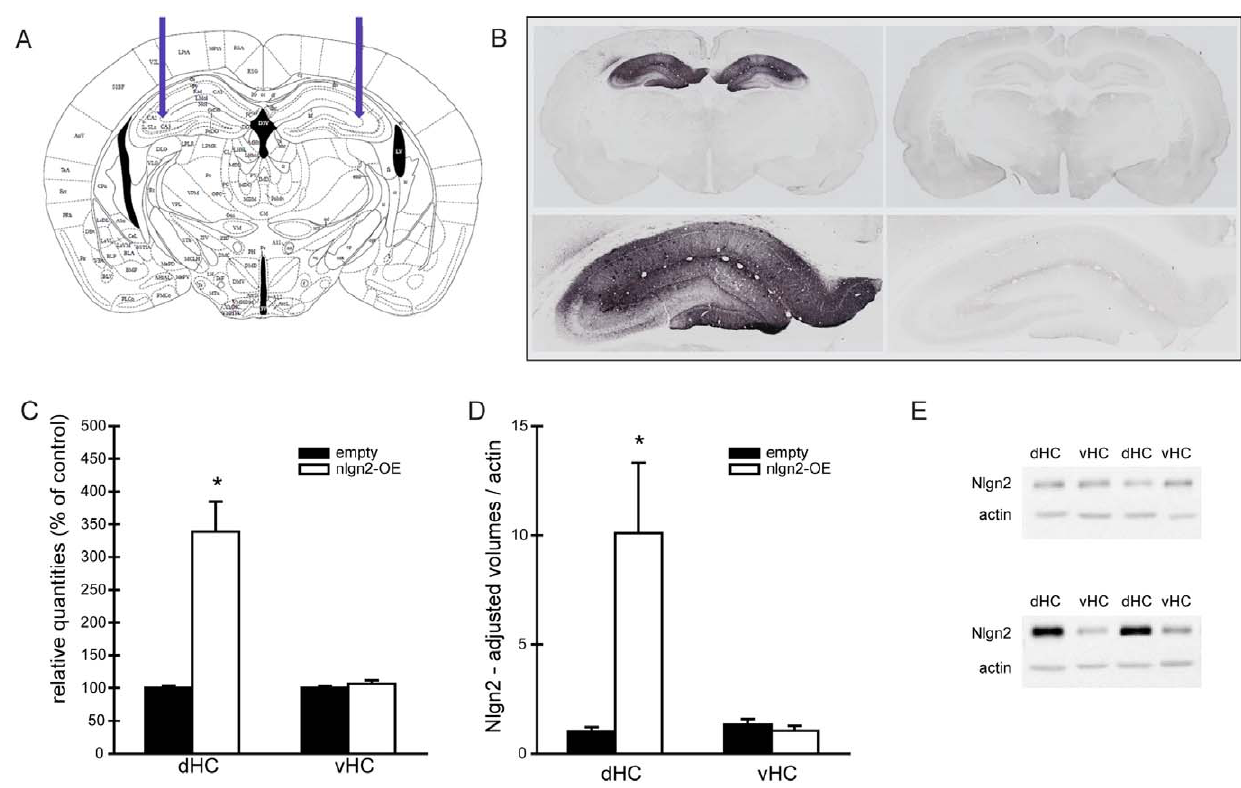
Figure 1. Verification of viral nlgn2-overexpression. A, Targeted area in the hippocampus for virus injections. B, DAB immunohisto- chemistry for nlgn2 in coronal sections from nlgn2-OE (left column) and empty (right column) with 20 6 magnification of the hippocampus (bottom panel). C, Relative quantities of nlgn2 measured in dorsal (dHC) and ventral hippocampus (vHC) (dHC: T (4.038) = 2 5.193, p , 0.01; vHC: T (9) = 2 1.117, p . 0.05). D–E Western blot analysis of synaptoneurosome. D, Nlgn2-OE rats showed significantly increased levels of nlgn2 in the synaptoneurosome compared to empty virus controls concerning the dorsal hippocampus (T (4.027) = 2 2.797, p , 0.05), but not in the ventral parts of the hippocampus (T (9) =0.836, p . 0.05). E, representative western blots from synaptoneurosomes of the dorsal (dHC) and the ventral hippocampus (vHC) of empty virus controls (upper panel) and nlgn2-OE animals (bottom panel). Empty n=6, nlgn2-OE n=5. ns=Not significant, *significantly different from empty animals.